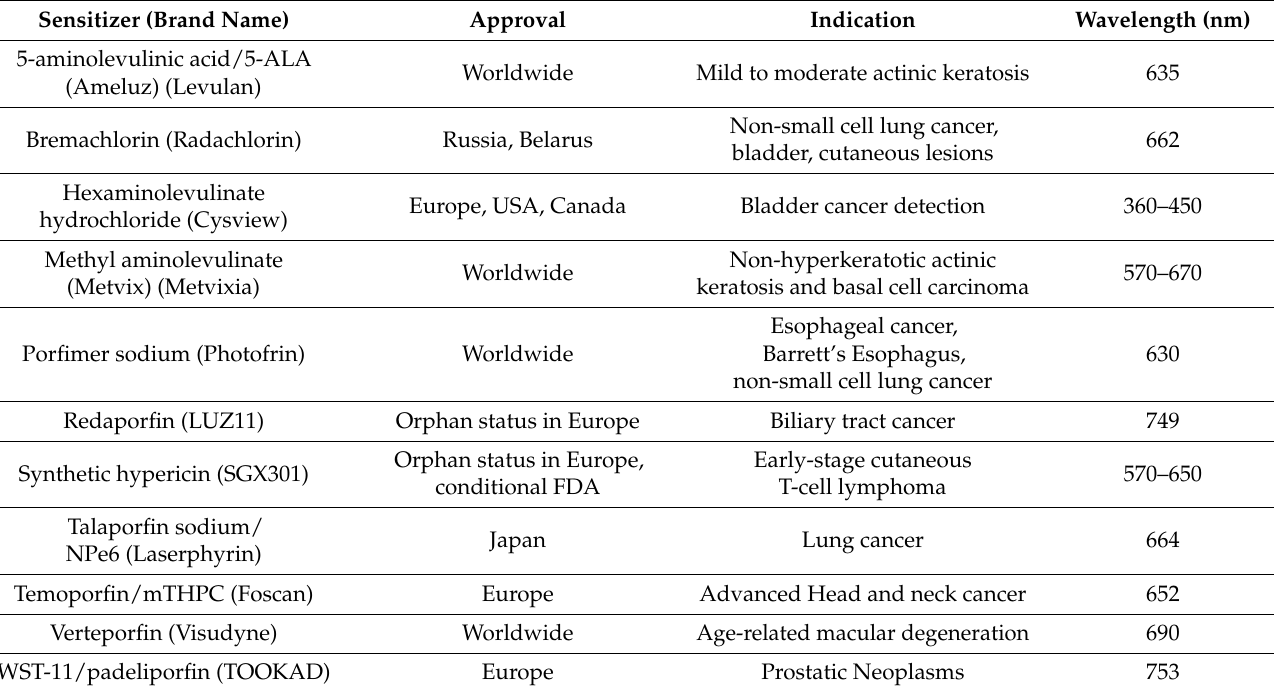
Table 1. Overview of notable clinically used